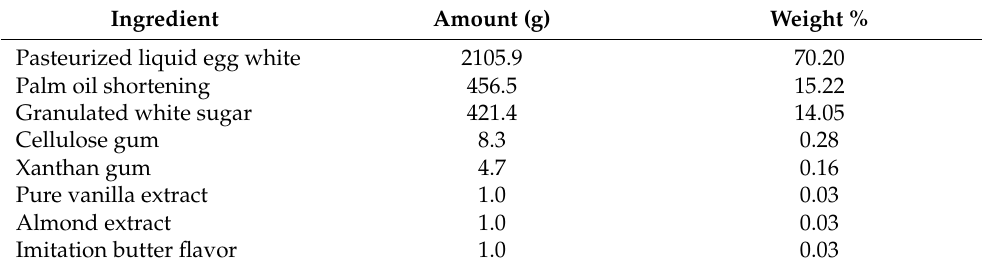
Table 2. Composition of seven servings of the mixed macronutrient tolerant test (MMTT). Individual servings of 403 g were provided to participants to be consumed in a five-minute